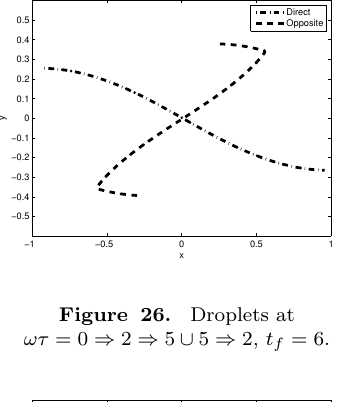
Figure 27. β ( l ) stac for ωτ = 0 ⇒ 2 ⇒ 5 ∪ 5 ⇒ 2, t f = 6.